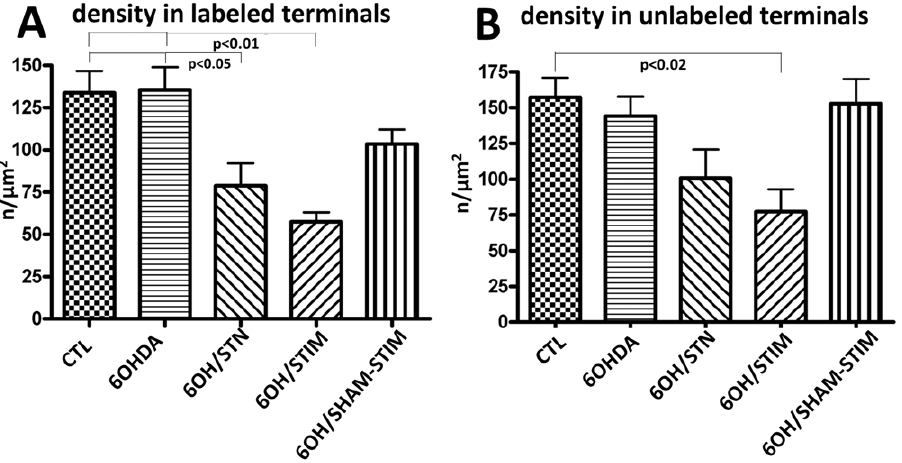
Figure 5. Density of immuno-gold labeled glutamate in asymmetric terminals. (A) In VGLUT1- labeled terminals there was no change in glutamate density with 6OHDA lesions. In 6OHDA-lesioned rats, STN lesions resulted in a decrease in glutamate particle density in VGLUT1- immunolabeled terminals (p , 0.05), as did STN stimulation (p , 0.01). 6OHDA-lesioned rats which underwent STN electrode placement alone did not show significant changes compared with 6OHDA alone. (B) Glutamate immuno-gold particle density in non-VGLUT1-immunolabeled terminals. There was no change in glutamate density in 6OHDA-lesioned rats in non-VGLUT1-immunolabeled, thalamostriatal terminals. There was a decrease in glutamate particle density with STN stimulation (p , 0.02) as compared with controls, although only a trend to decrease (p , 0.09) compared with